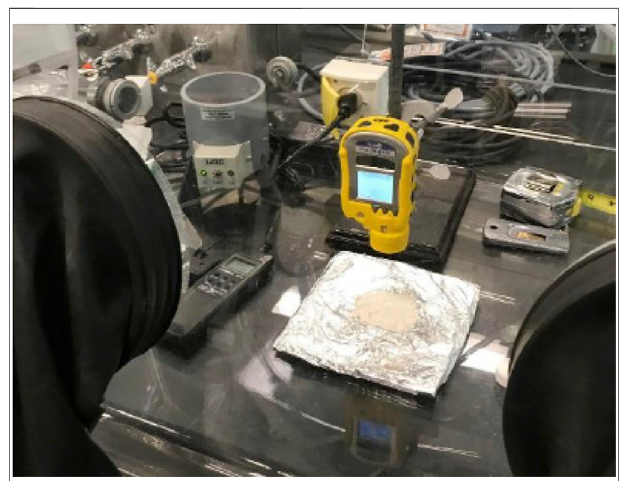
Figure 2 . The glovebox was out fi tted with a custom moisture control system to maintain humidity levels to within ±2 ° C of a desired target dew point. Unless otherwise noted, the humidity level